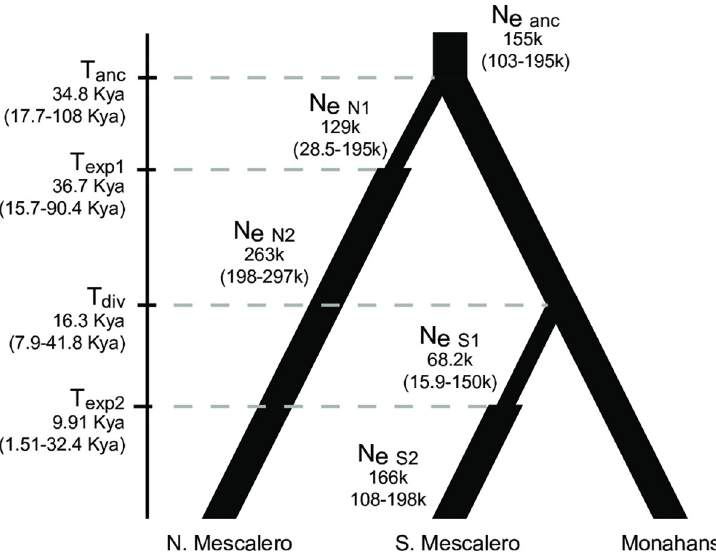
Fig 5. Demographic estimates for best supported model in ABC analyses. Scenario best supported by ABC analyses. Estimates of divergence and expansion times as well as current and historical effective population sizes are indicated.